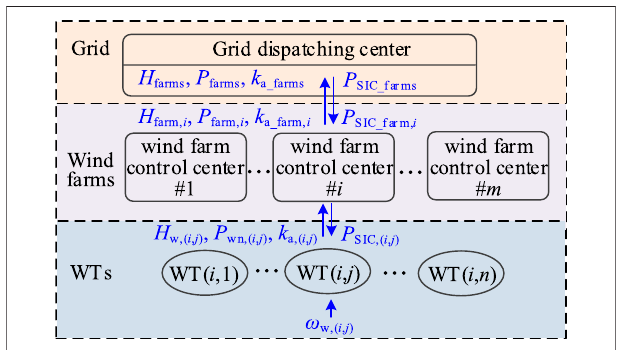
FIGURE 3 | D-PMSG ’ s FR capability coef fi cient versus rotor